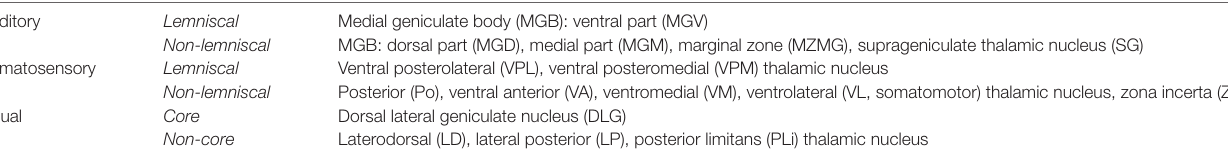
TABLE 2 | Sensory thalamic nuclei containing retrogradely labeled somata after injections of FG into the gerbil’s A1, S1, and V1. Auditory